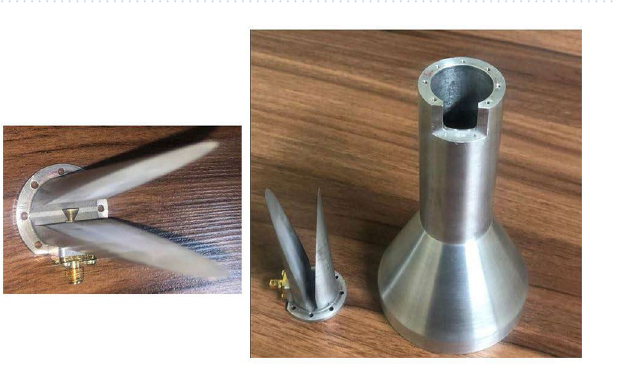
Figure 12. Fabricated horn antenna along with its wideband coaxial to waveguide